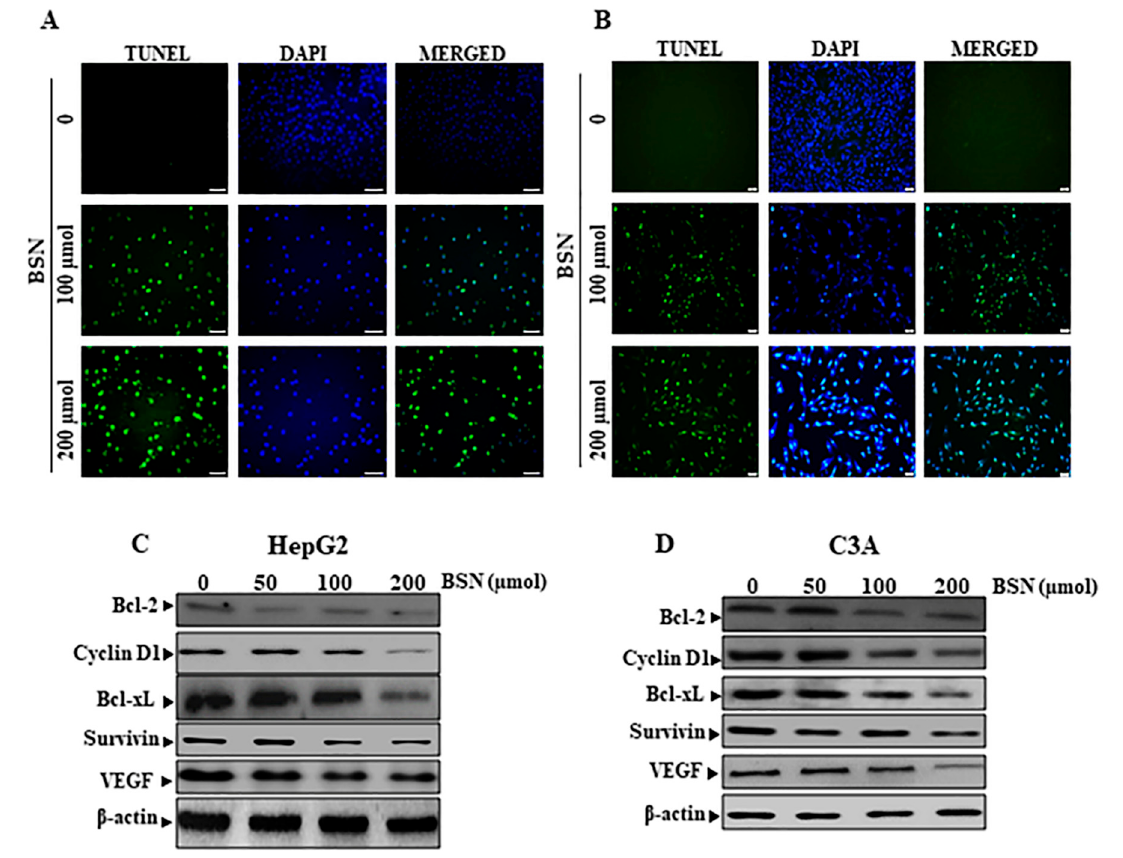
Figure 6. BSN induced apoptosis in hepatic carcinoma cells. ( A , B ), TUNEL staining for in situ apoptosis detection in HepG2 and C3A cells. Apoptotic-positive cells from three samples were averaged. Scale bar = 50 µ m. ( C , D ) BSN was added to HepG2 and C3A cells (2 × 10 6 /mL) for 48 h, and the indicated dose intervals; after that, whole-cell extracts were prepared, and 40 µ g of those extracts were separated on a 10–12% SDS-PAGE, Slicing membranes according to molecular mass and probing antibodies against Bcl-2, Bcl-xL, surviving, and VEGF. Experiments were conducted in triplicate. Tukey’s post hoc test was used in this study to analyze the data. p < 0.05 was considered significant. Graph Pad prism was used. Data are presented as the mean ± SD.